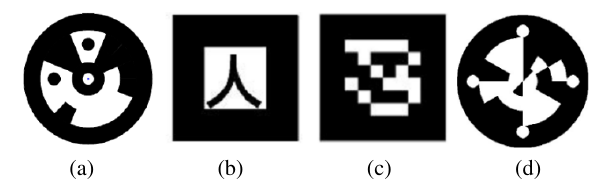
Figure 4: Planar marker systems utilized in computer vision (K¨ohler et al.,